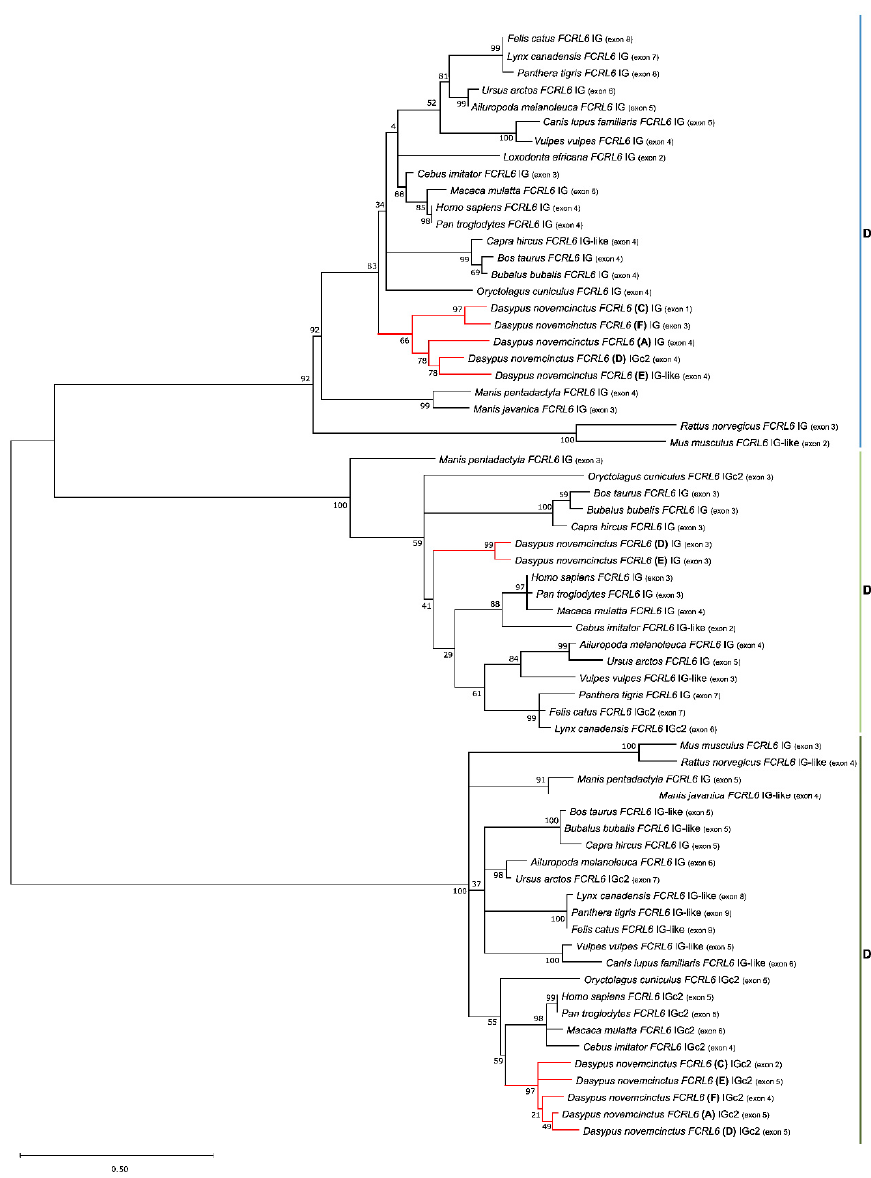
Figure 3. Phylogenetic tree of the predicted amino acid sequences for FCRL6 Ig domains from D. novemcinctus and a panel of mammals ( n = 20). The maximum likelihood (ML) method and the JTT + G + I model of amino acid substitution were used for analysis and assembly. D1 corresponds to the membrane-distal Ig-like domain, D2 to a middle Ig-like domain, D3 to a membrane-proximal Ig-like